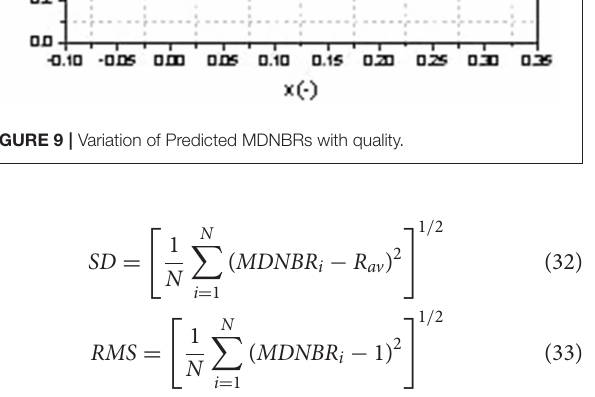
Figure 6 compares the predicted and experimental CHF values for 417 data points. The average value of MDNBRs, R av , is 1.0025, with a standard deviation, SD, of 10.51%, and a root-mean-square error, RMS, of 10.50%. Almost all of the data are predicted within the 30% error ± band. Applying the original model of Weisman and Pei (1983) leads to a R av of 0.88 with a standard deviation of 22% for the same set of data points. This